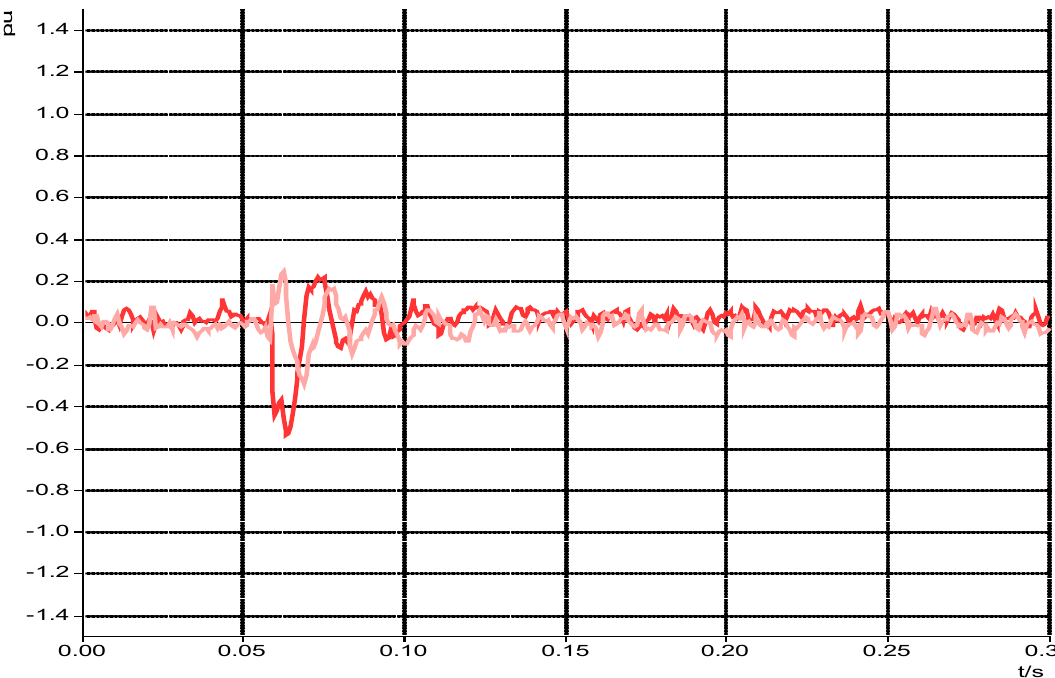
Figure 25. Voltages in a (cid:1856)(cid:1869) reference frame for a negative sequence (NEG).